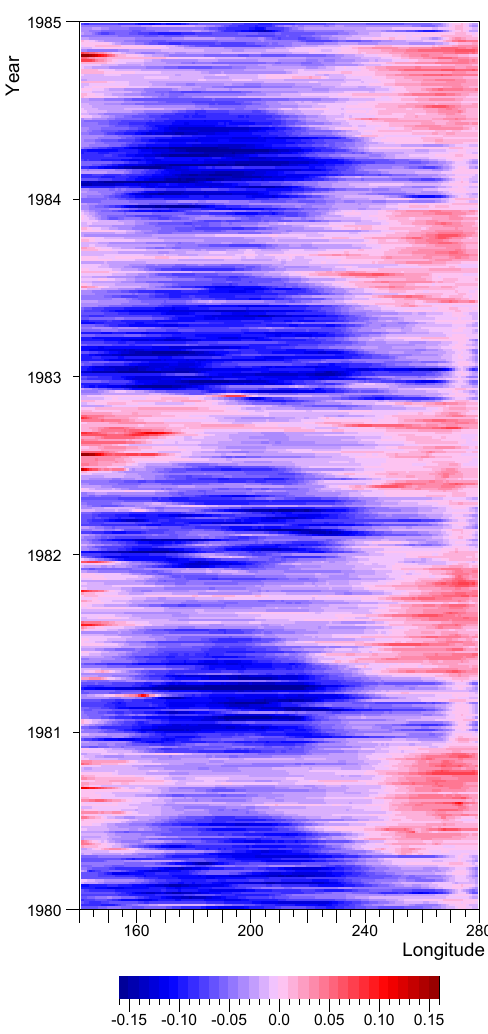
Figure 9. Eastward component of wind stress (Pa) at 6 ◦ N in the equatorial Pacific between 140 and 280 ◦ E (80 ◦ W), between 1980 and 1985.